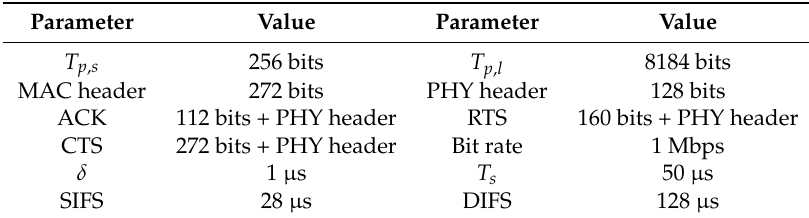
Table 1. Values used for simulation